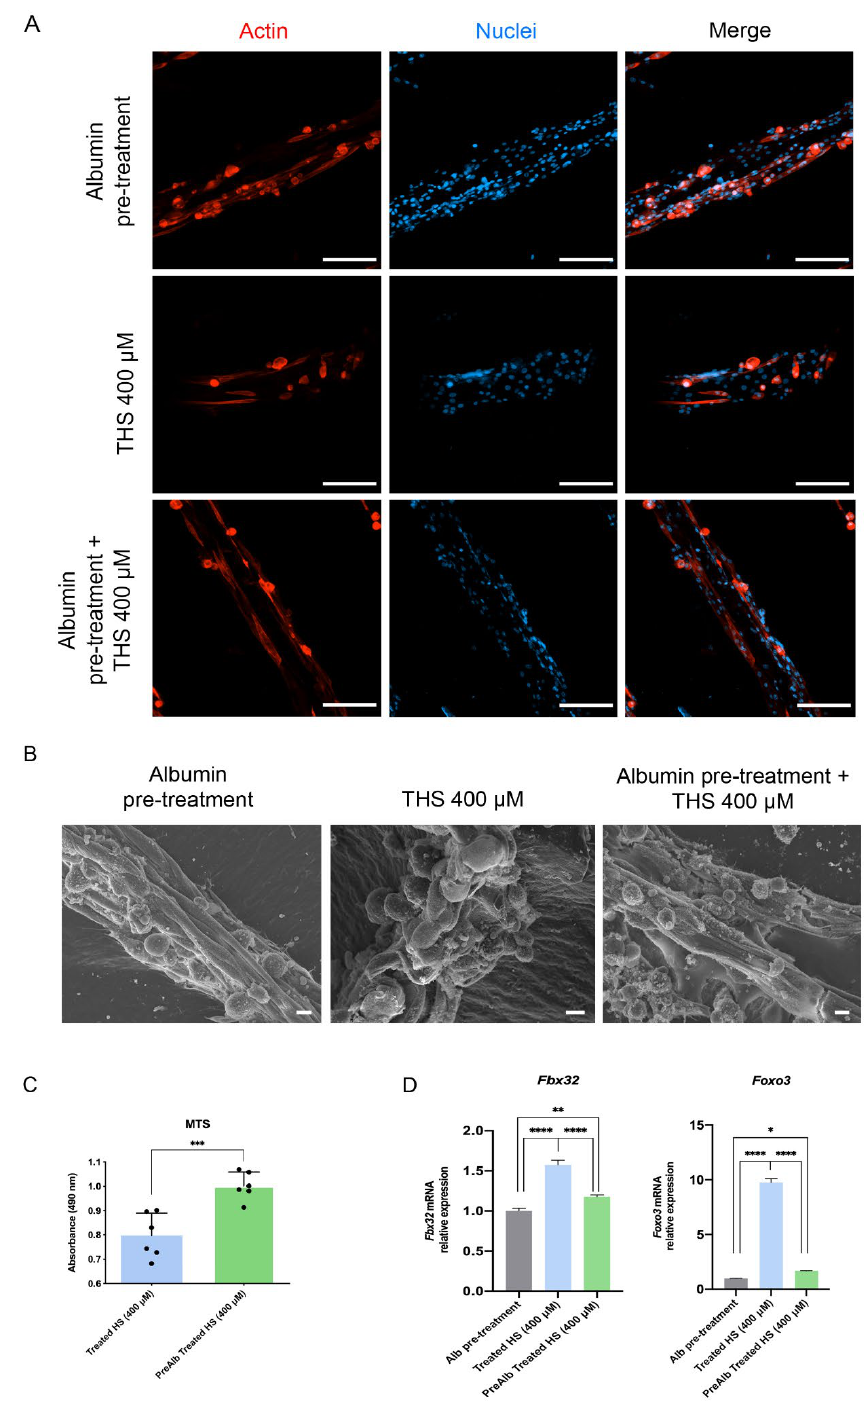
Figure 7. Effect of albumin pre-treated hepatocytes’ supernatant on 3D skeletal muscle tissues. ( A )